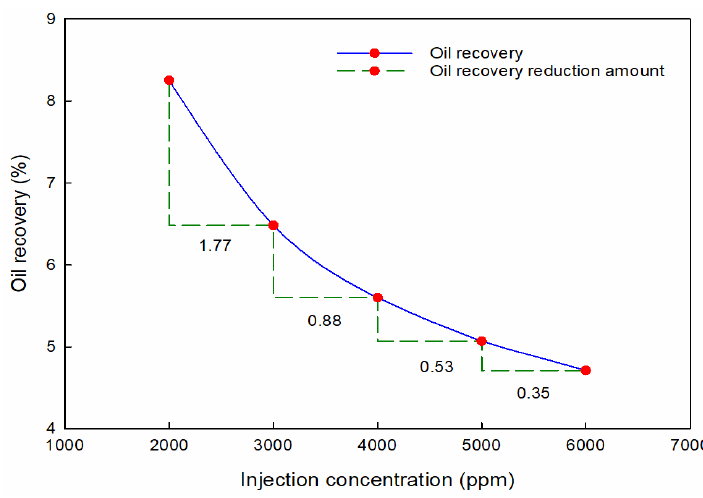
Figure 8. Oil recovery with different injection concentrations of PMs.